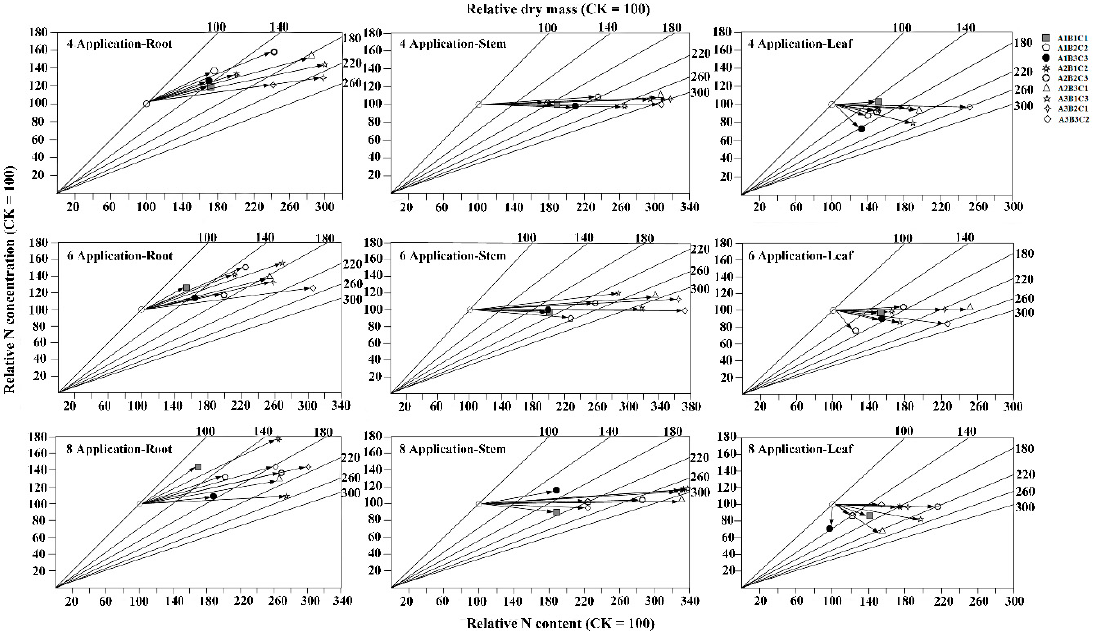
Figure 4. Vector diagram of relative changes in dry mass, N content, and N concentration at the end of the growing season after application of NPK fertilizer. Note that this vector diagram is based on the status of CK.